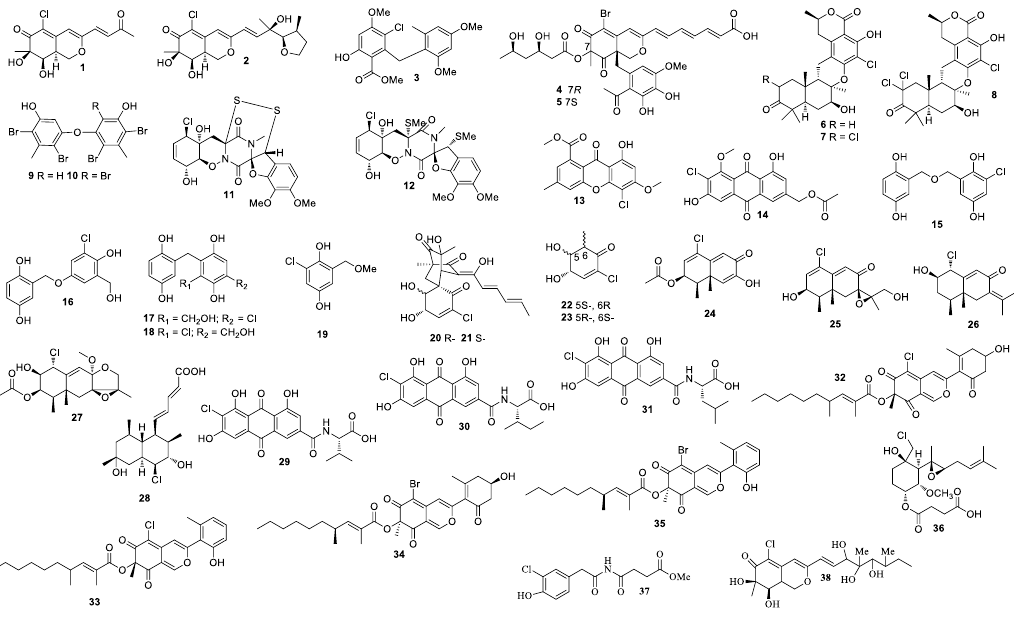
Figure 1. Structures of compounds 1 – 38.